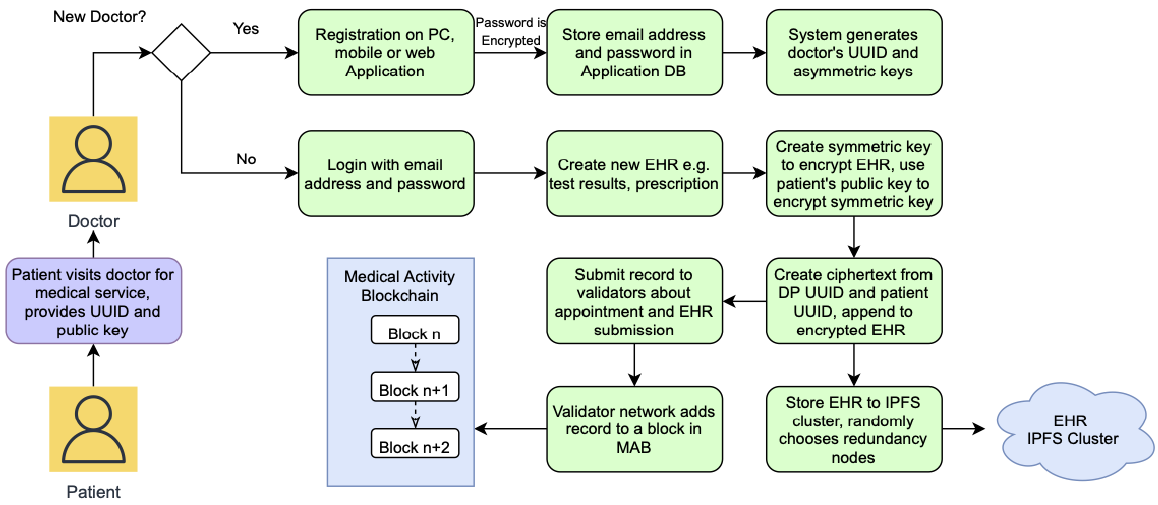
Figure 16. Data provider EHR creation and commit process diagram. This process is better explained using a sequence diagram shown in Figure 17.